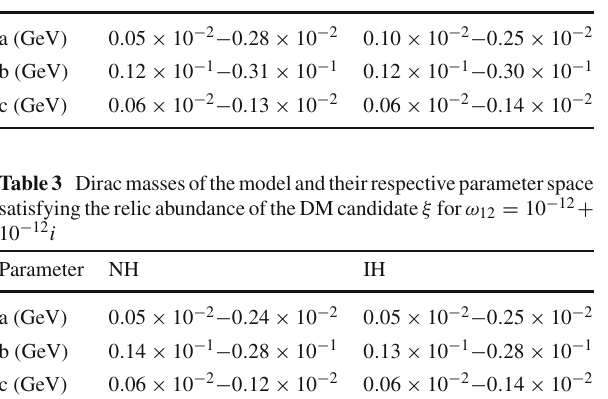
similar plot for a and c. This result corresponds to benchmark points ω for IH